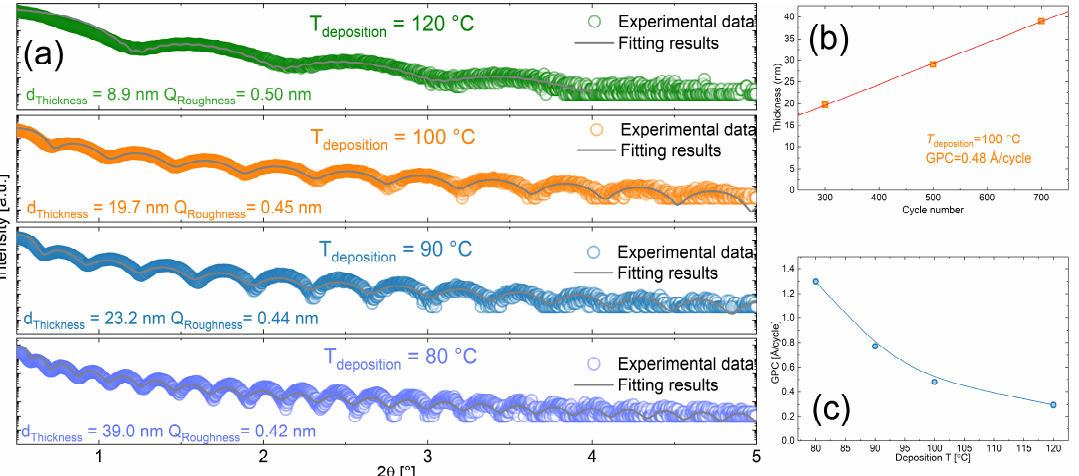
Figure 1. ( a ) XRR data of ALD coating with SbO x thin film for 300 cycles at different deposition temperatures. ( b ) Thickness data determined via XRR plotted vs. cycle number. ( c ) Growth per cycle (GPC) data determined via XRR plotted vs. deposition temperature.